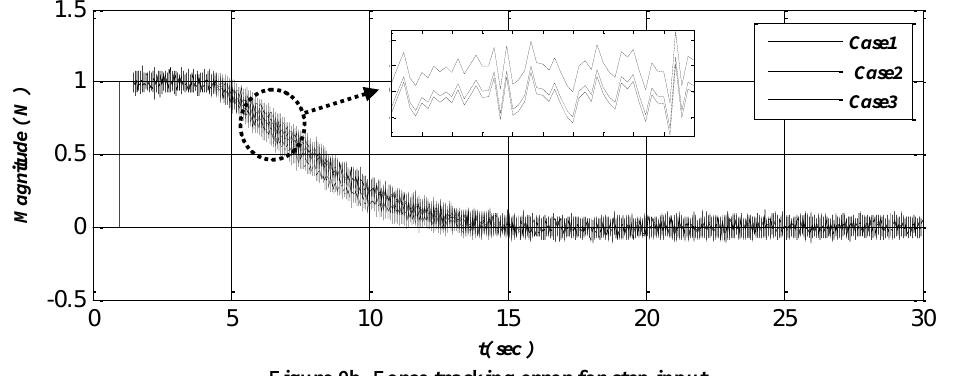
Figure 9b. Force tracking error for step input